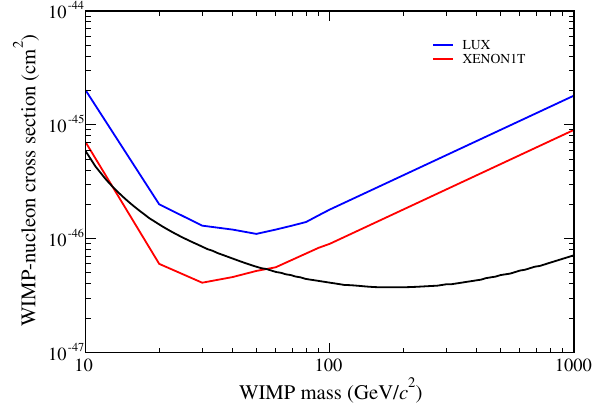
Fig. 4 Expected background-free 90% confidence level sensitivity for a Au target with an expected 3.2 events and a 100-kg-year exposure (black line), assuming all the WIMP-induced events are identified, and exclusion limits from LUX [21] (blue line) and XENON1T [23] (red line)